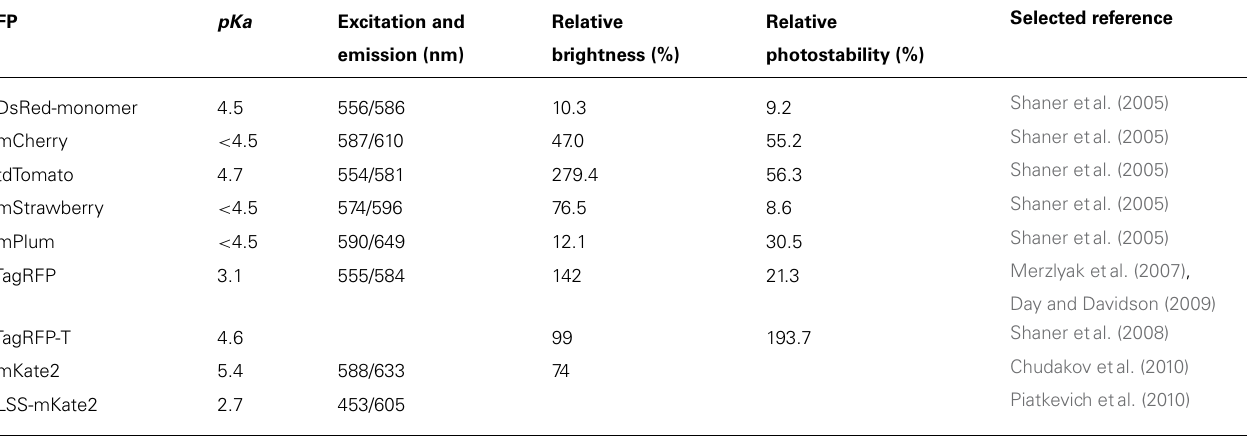
Selected reference Relative Relative emission (nm) brightness (%) photostability (%)